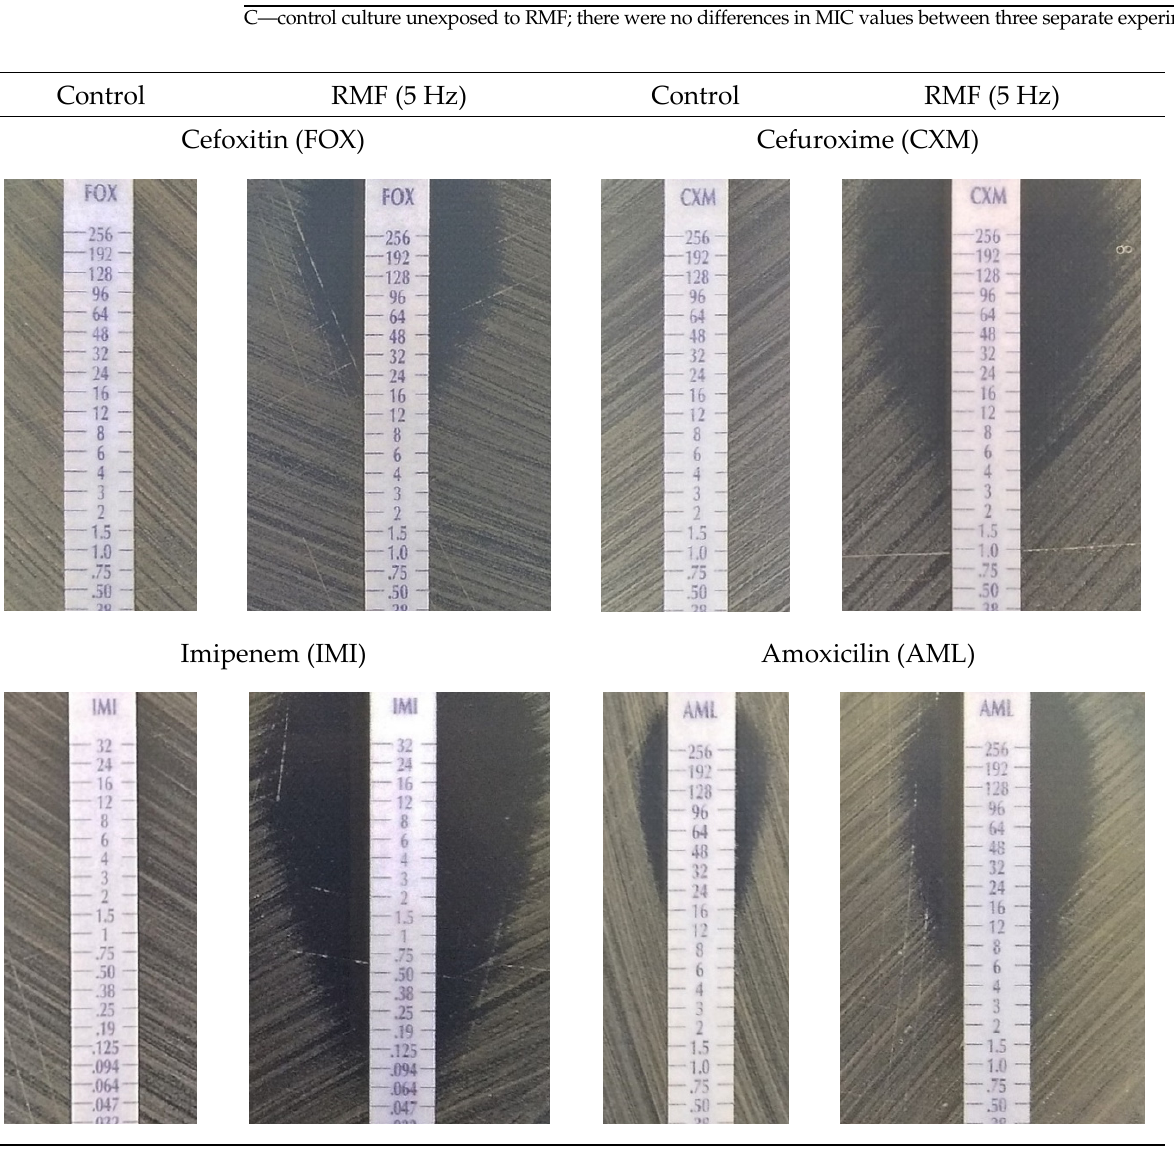
Figure 3. Representative pictures of gradient MIC strips (E-tests) with β -lactam antibiotics in control and RMF-exposed (5 Hz) cultures of the MRSA 1 strain.